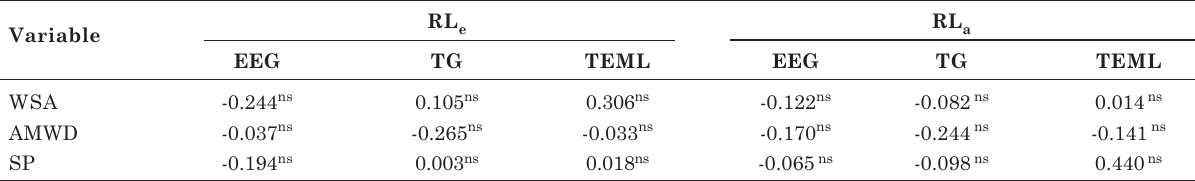
Table 4. Pearson’s correlation coefficients between variables - aggregate stability (WSA), aggregate mean weight diameter (AMWD) and spore production (SP) - and easily extractable glomalin (EEG), total glomalin (TG) and total external mycelium length (TEML) in the 0.00-0.10 m layer after the first sugarcane